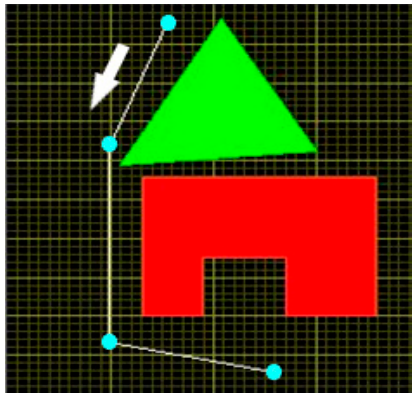
Figure 13. Path generated for bypassing adjacent no-travel zones.